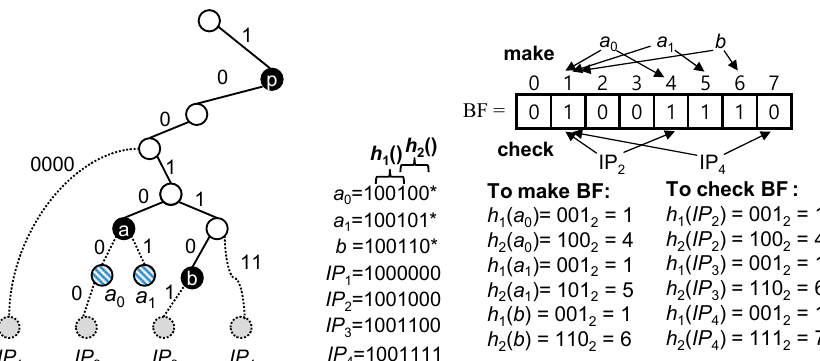
Figure 3. Prefix caching using a single Bloom filter with two hash functions.